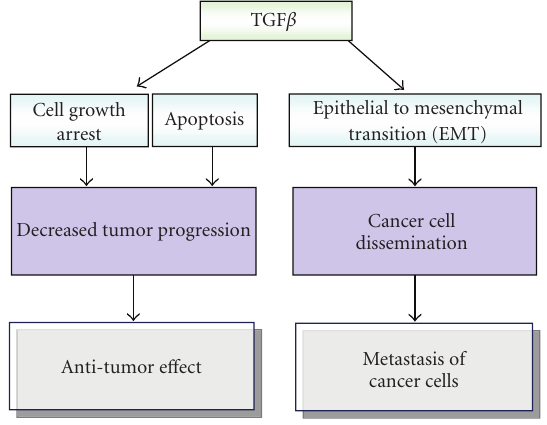
Figure 1: A scheme showing the opposing e ff ects of TGF β on tumor growth and